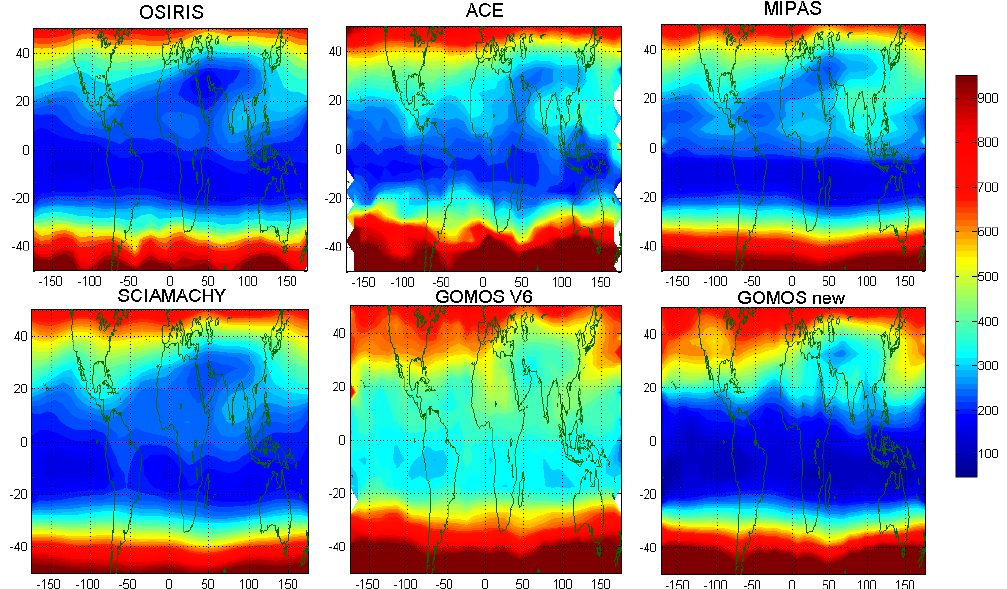
Figure 15. Mean ozone mixing ratio (ppb) at 100hPa in the summer season (June–August), as inferred from all available measurements by OSIRIS, ACE-FTS, MIPAS, SCIAMACHY, and GOMOS (V6 and ALGOM2s retrievals, “GOMOS